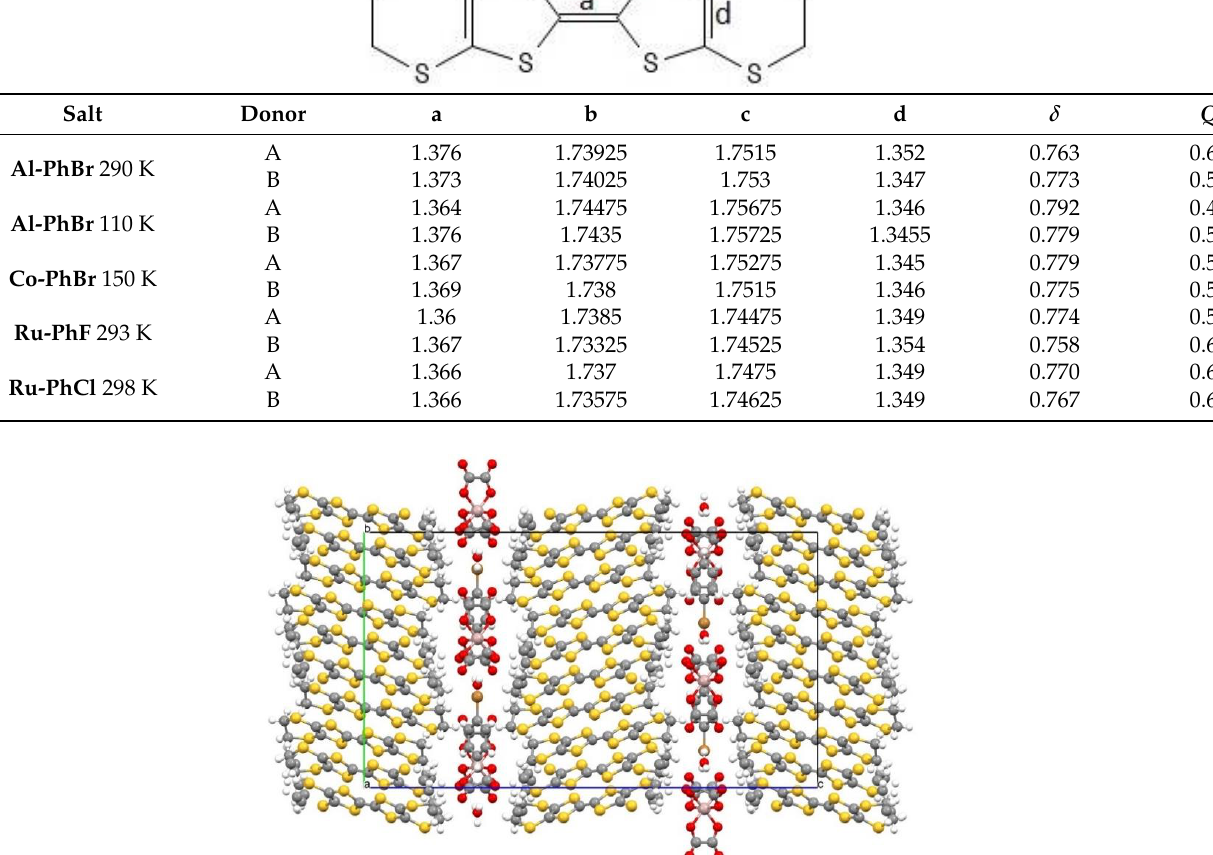
Figure 1. Layered structure of Al-PhBr . The other salts reported in this paper are isostructural. Carbon atoms are grey, hydrogen atoms white, oxygen atoms red, sulphur atoms yellow, aluminium atoms pink, and bromine atoms brown. The b axis is shown in green, and the c axis is shown in blue.